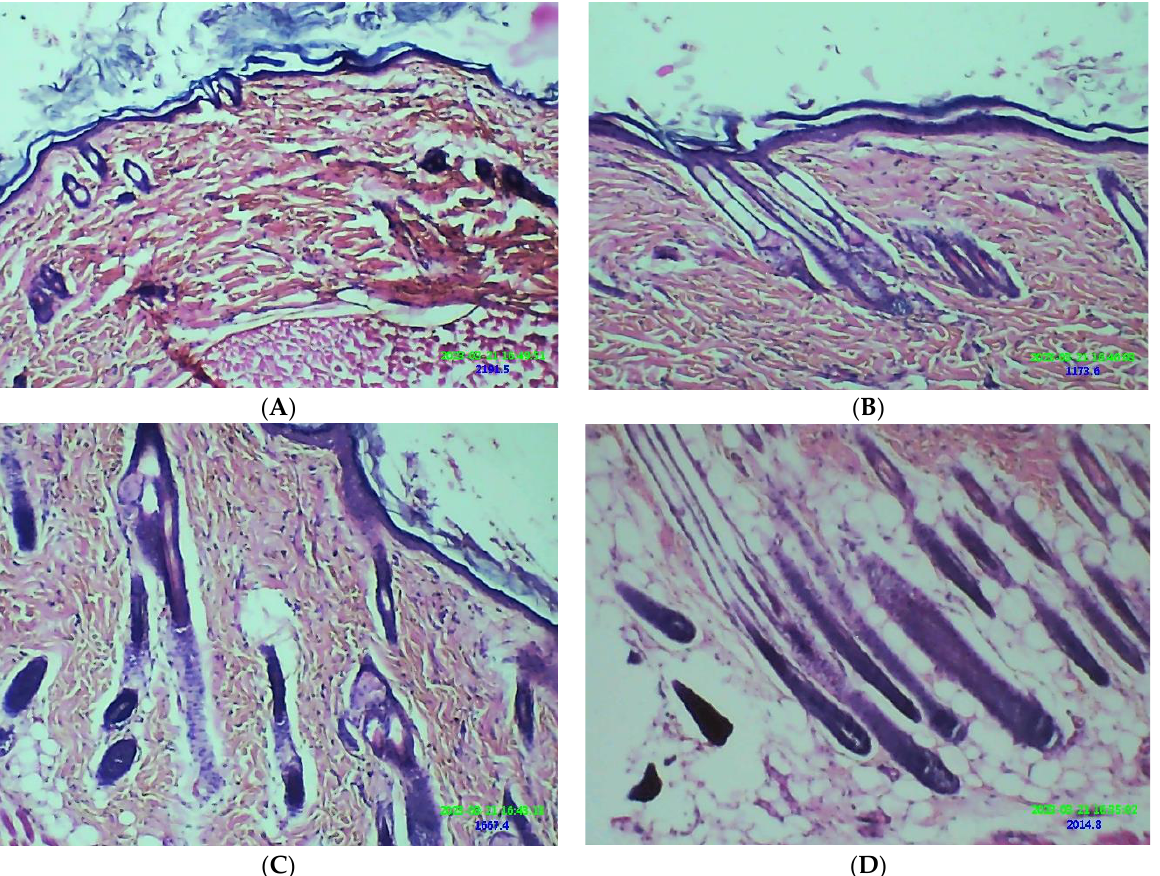
Figure 9. Comparison of hair regrowth pattern in rat skin histogram of following groups; ( A ) testosterone solution only; ( B ) testosterone with β -ST gel; ( C ) testosterone + CUBs; and ( D ) testosterone + CUBs-MN D .